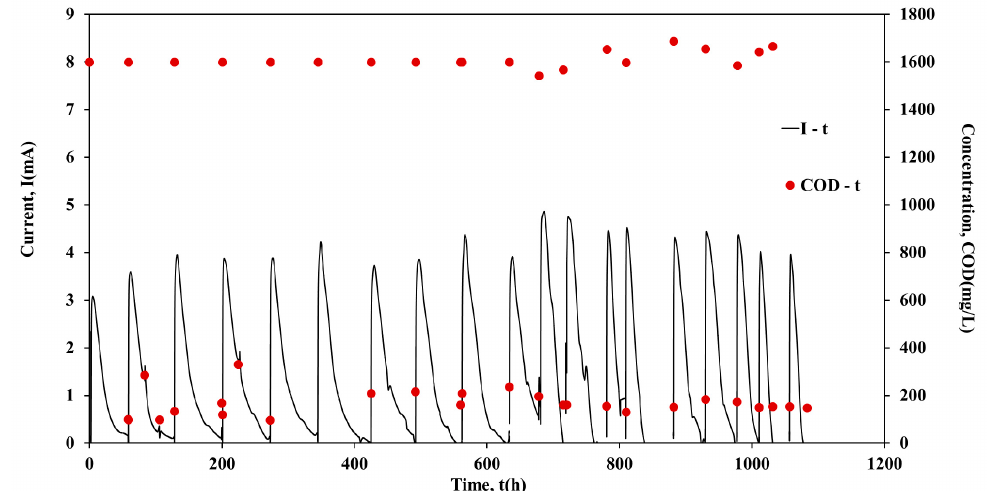
Figure 2. Current output (mA) and COD concentration (mg/L) versus time of Cell 2, during batch operation.